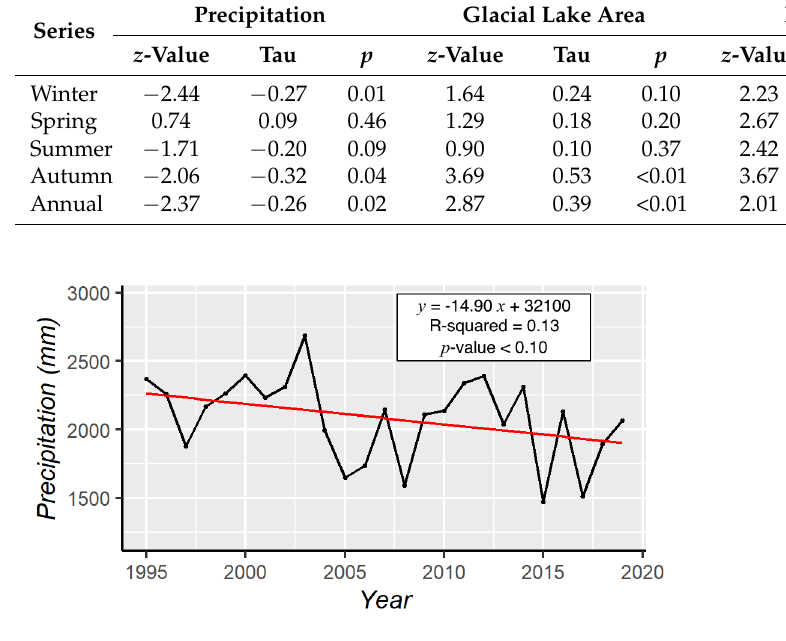
Figure 5. Linear regression trends of annual precipitation.